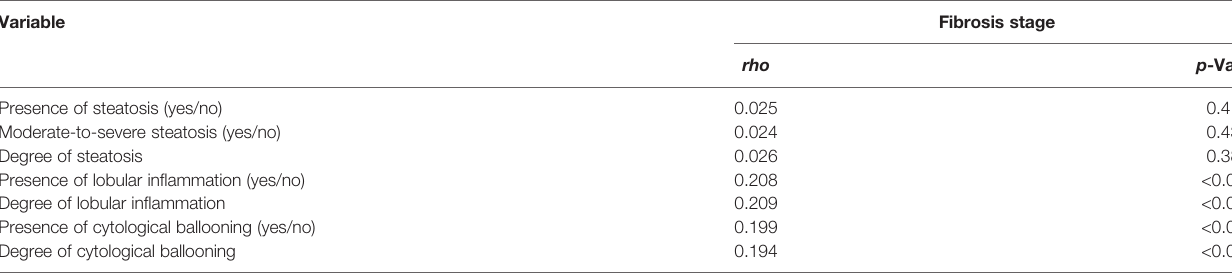
TABLE 3 | Spearman ’ s correlation analysis between three histological changes and severity of fi brosis. Variable